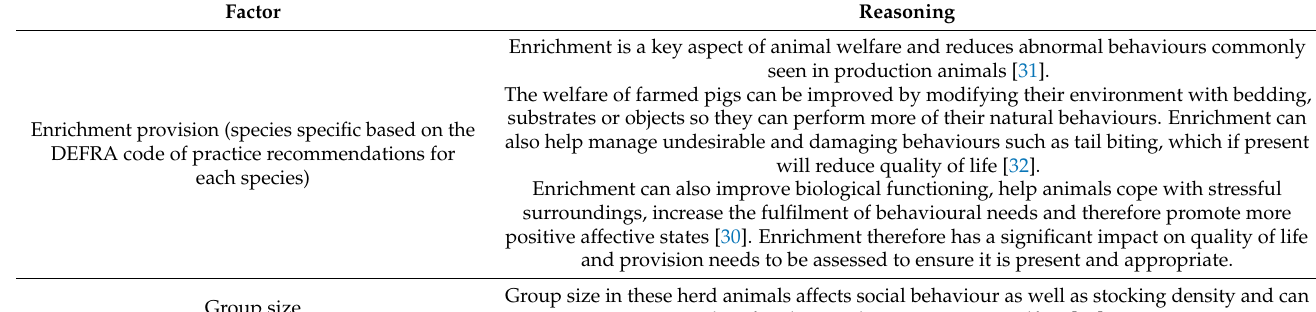
Table 1. Cont. Factor